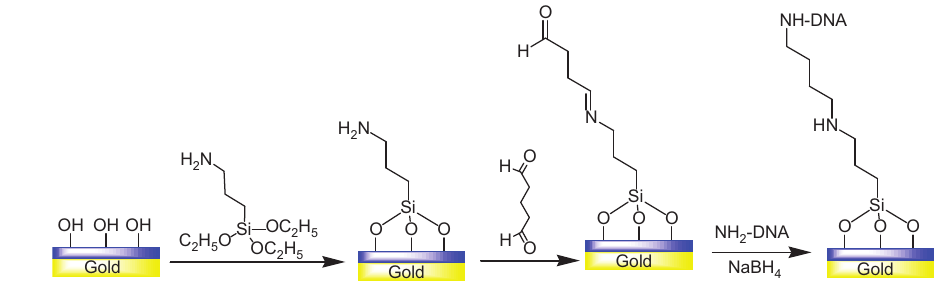
Figure 8 Schematic outline of the covalent linking of amine-terminated bioreceptors to silica coated SPR